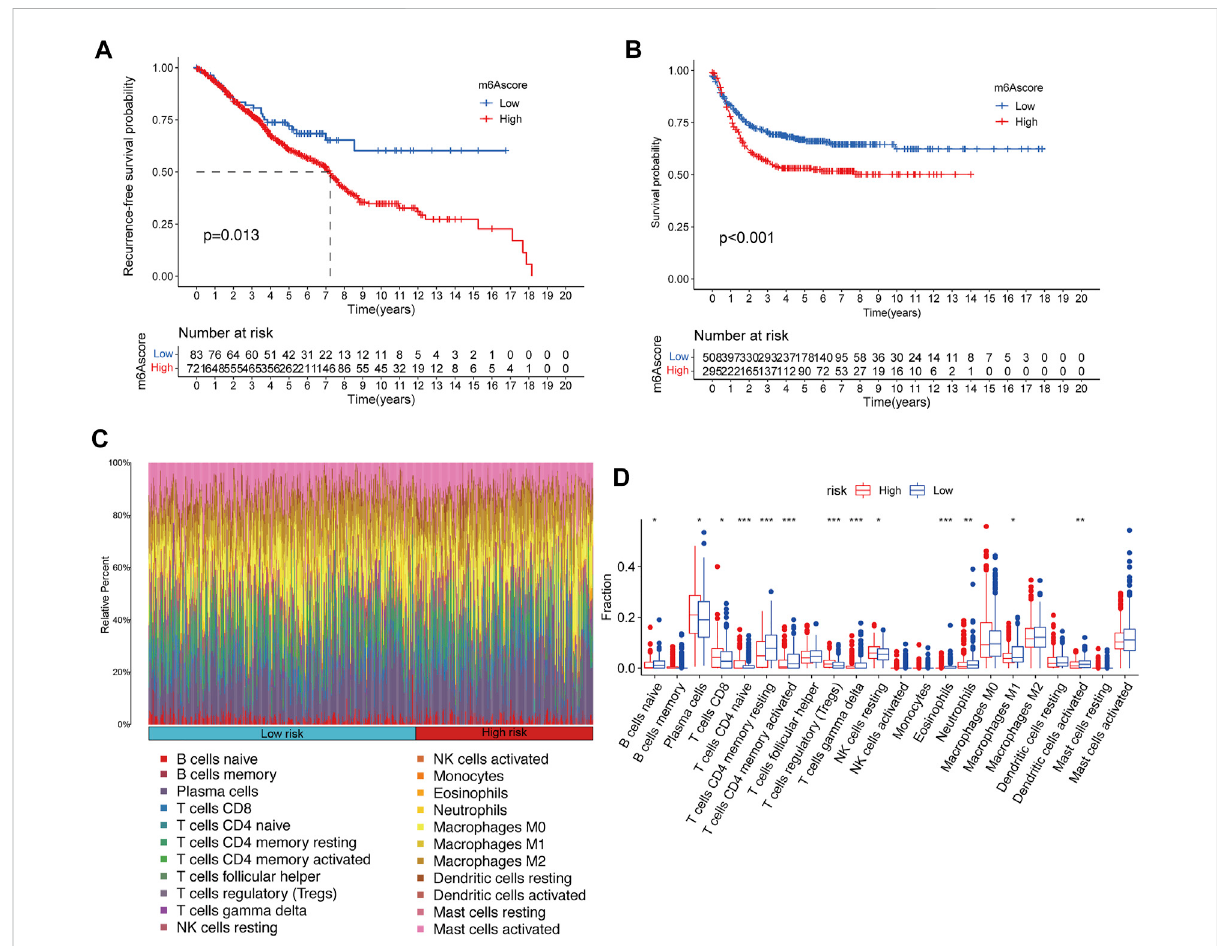
FIGURE 4 Construction of m 6 A signatures and TME cell in fi ltration analysis. (A,B) Kaplan – Meier curves of recurrence-free survival (A) and overall survival (B) for 804 CRC patients in the meta-GEO cohort with different m 6 A scores. (C) Bar plot visualizes the relative percent of 22 immune cells in